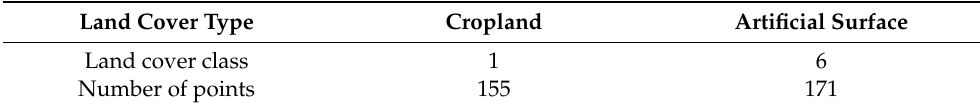
Table 4. Classification of land cover types in this